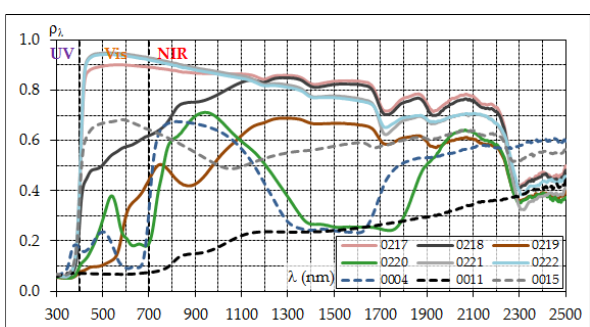
Figure 10. Sample set tested at EELab.